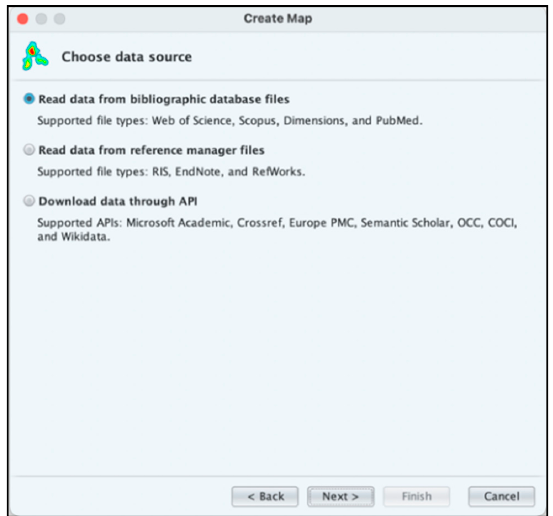
Figure A2. Selected “read data from bibliographic database file.